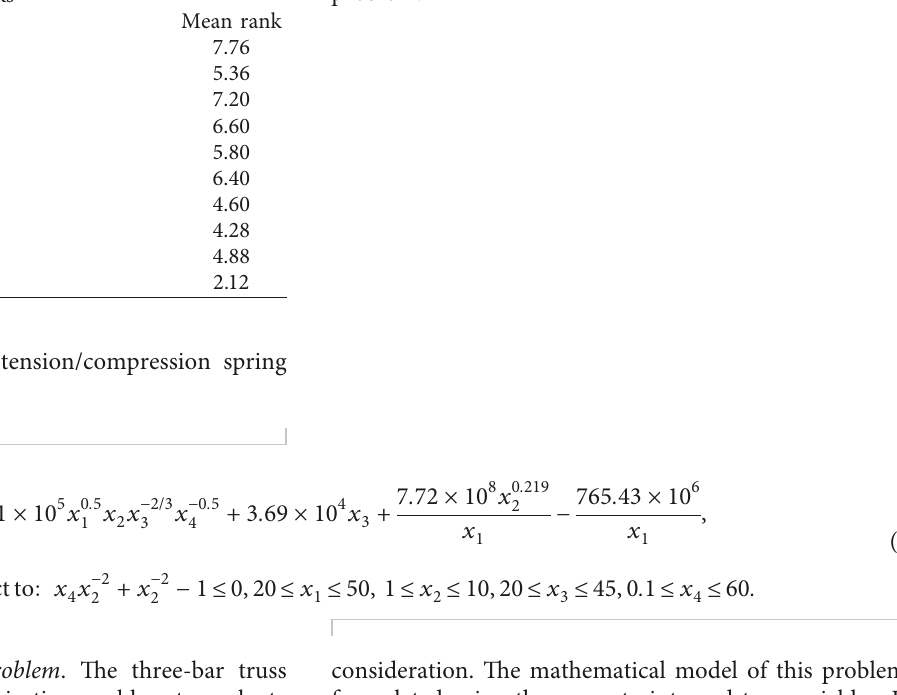
(1) P : Design of gas transmission compressor problem . 1 The basic purpose of the gas transmission compressor design challenge is to minimize the objective function utilizing four design variables which are length between compressor stations L � x , compression ratio that denotes the inlet 1 , and inner diameter of the pressure to the compressor r � x 2 pipe D � x . Figure 5 and (11) depict and formulate this 3 problem.